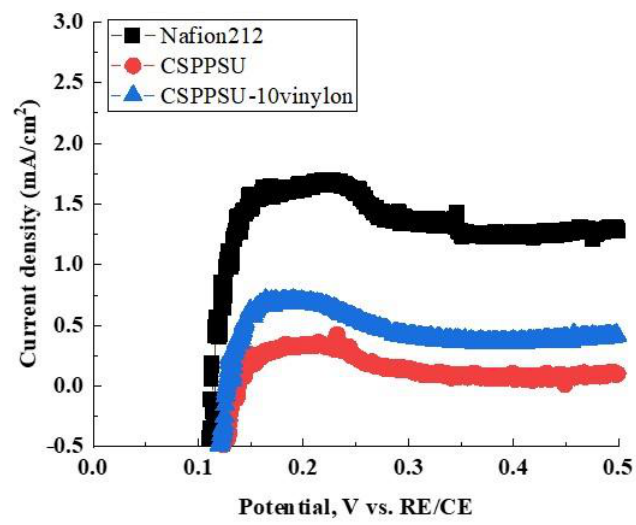
Figure 7. Hydrogen crossover properties of CSPPSU-10vinylon, CSPPSU, and Nafion212 membranes at 80 °C and 100% RH. Table 6. I-V and H 2 crossover data for single cells using the CSPPSU-10vinylon, CSPPSU, and Nafion212 membranes.